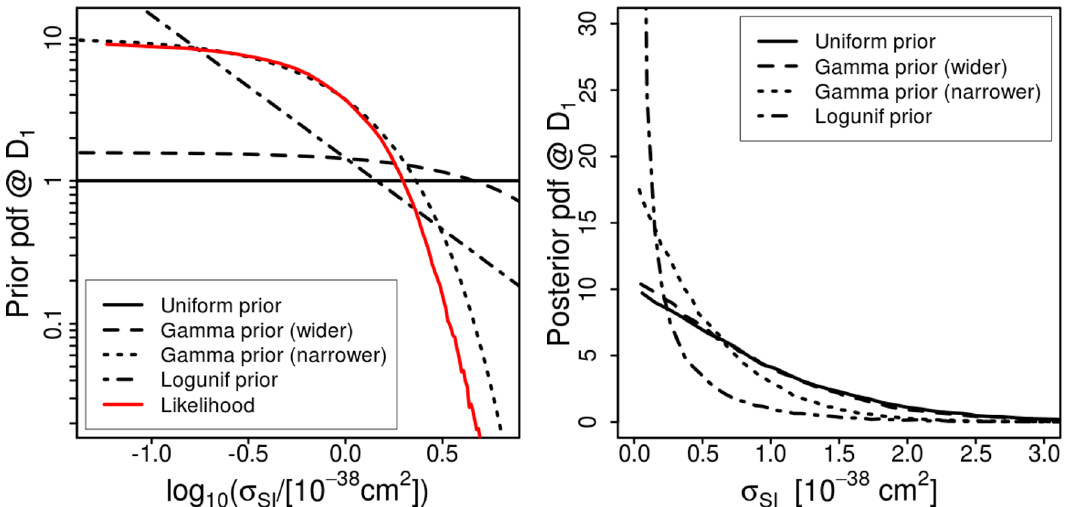
Figure 3 . Left : possible prior choices for the parameter (cid:27) SI . Right : resulting posterior p.d.f. after a fit over a pseudo-dataset generated from the background template.